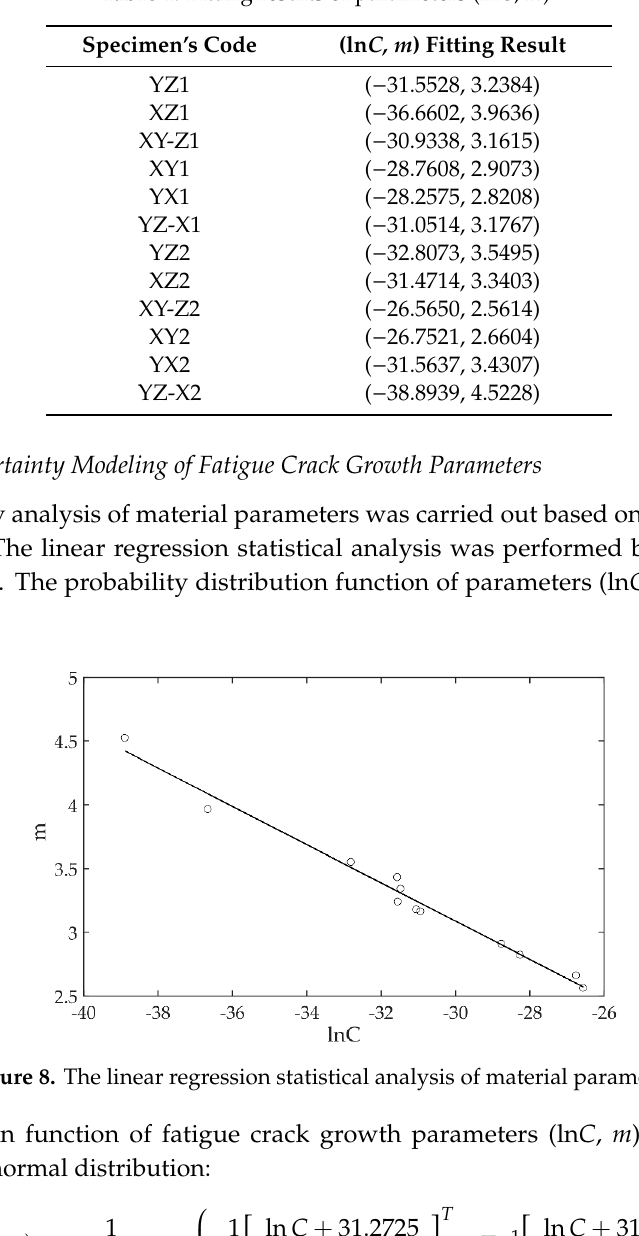
Table 4. Fitting results of parameters (ln C , m ).